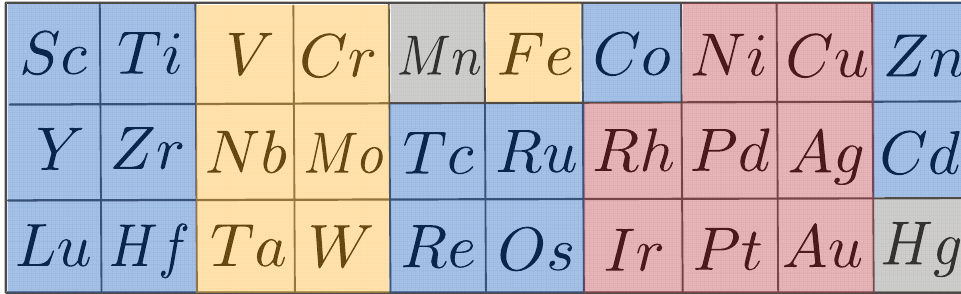
Figure 1. Of the transition metals, only Mn and Hg do not possess one of the three crystallographic structures HCP ( blue ), BCC ( orange ) or FCC ( red ) as ground state